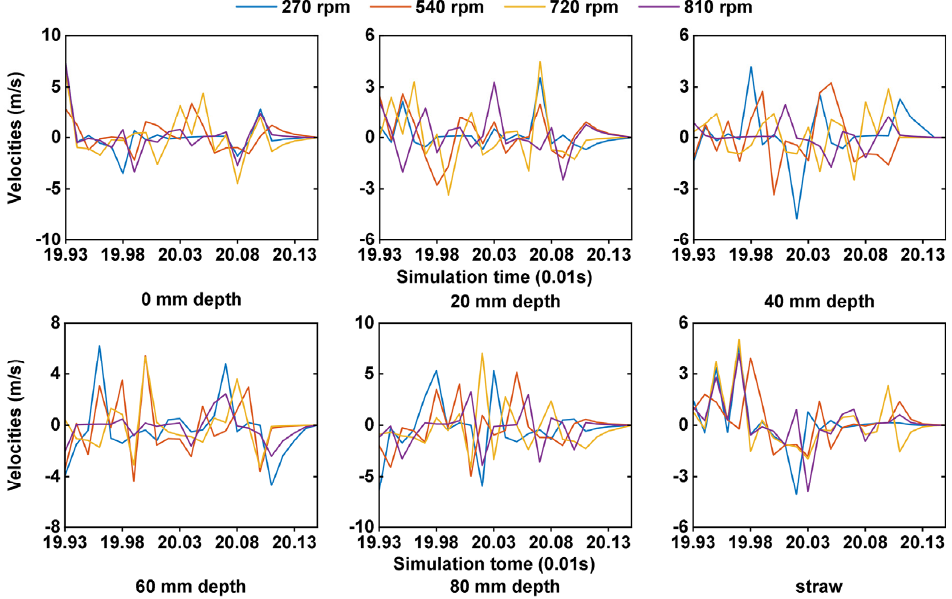
Figure 14. Vertical velocities particles at different depths and surface straws at different rotary speeds with or without air- fl ow.